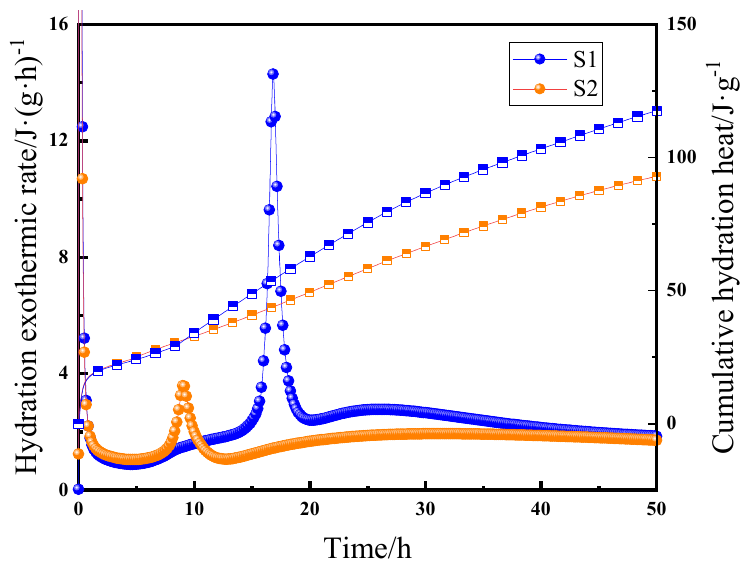
Figure 8. Rate of exothermic hydration and cumulative heat release. Table 7. Classification of the exothermic stages of hydration and the heat release and exothermic rate of each stage.